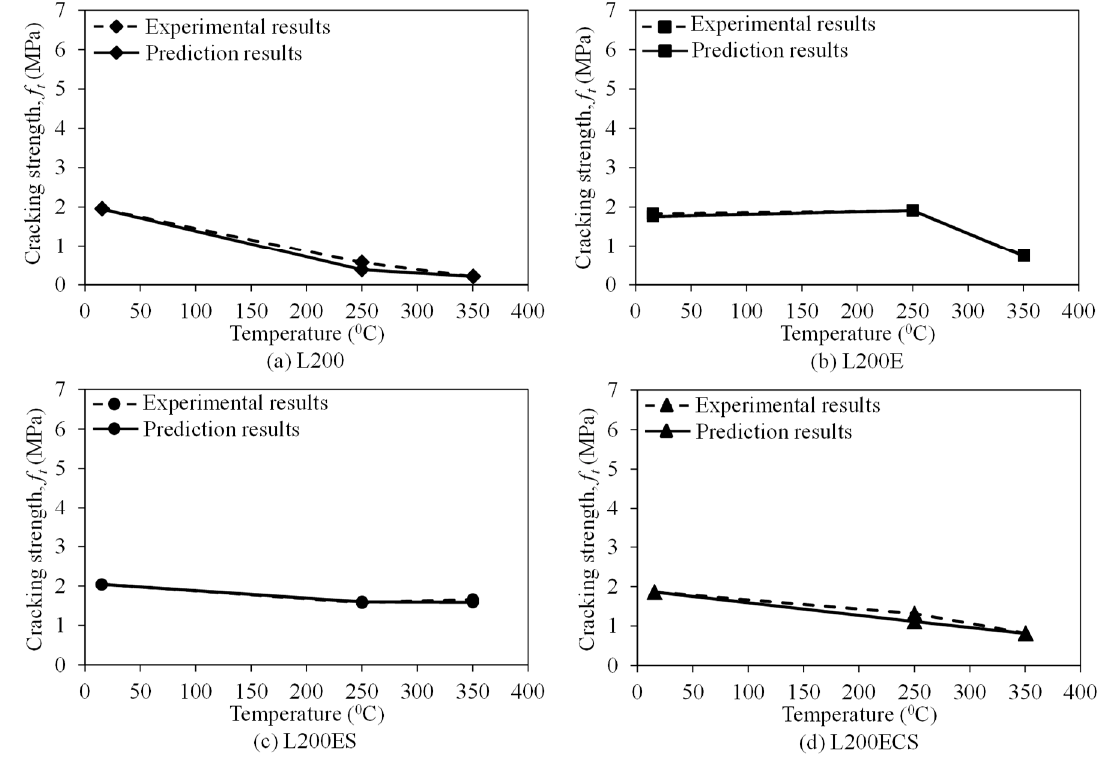
Figure 19. Predicted cracking strengths of the TRM specimens according to temperature.